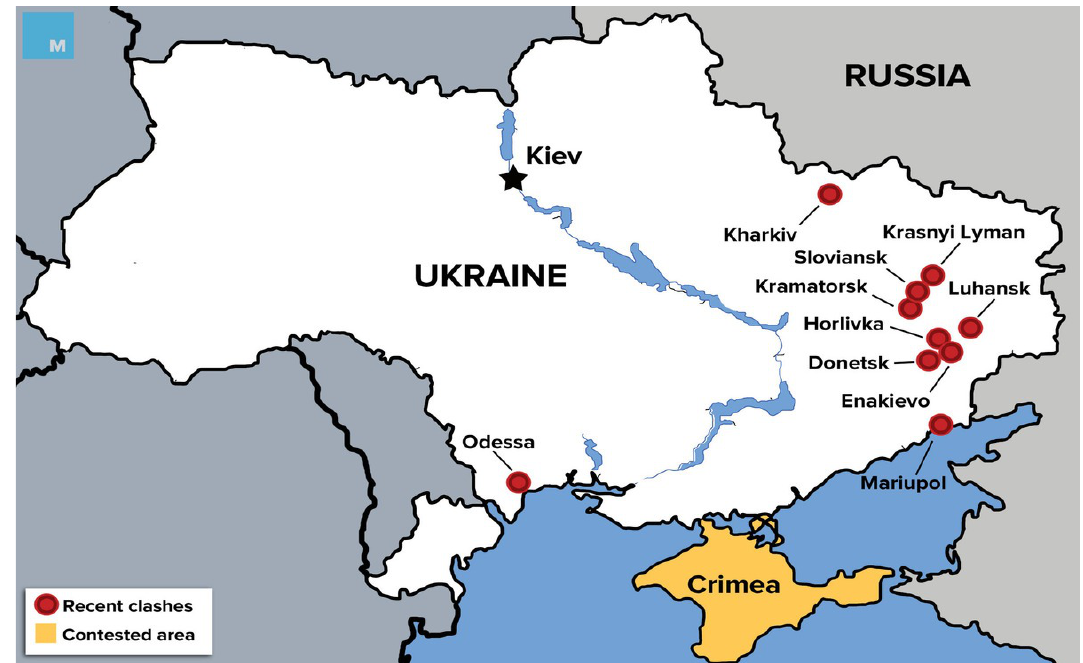
Figure 1. Map of Ukraine [ 21 ]